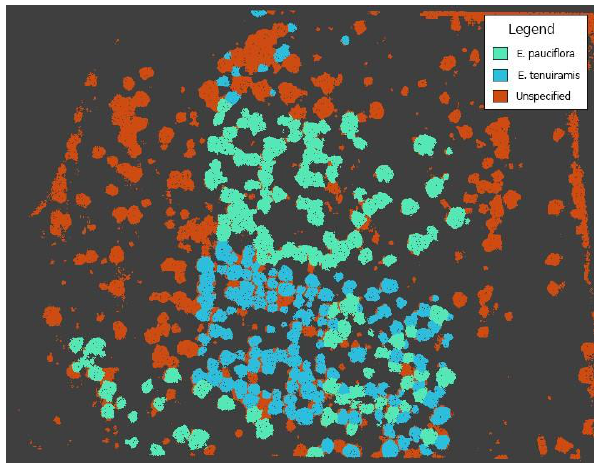
Figure 5. The segmented crowns coloured by their designated class. Table 1. Mean classification accuracy based on the spectral only, geometric only and combined feature sets of the hyperspectral point cloud Feature set